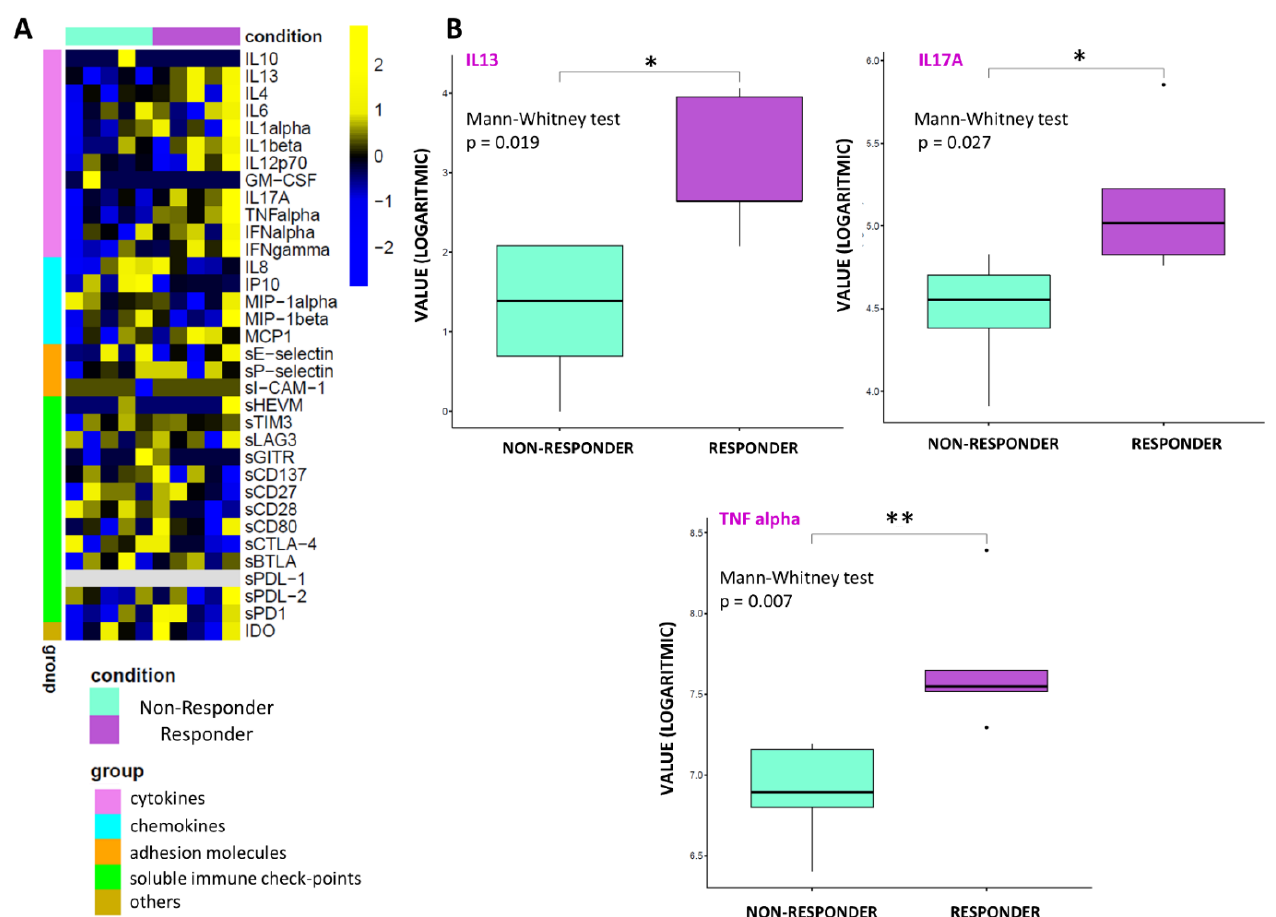
Figure 1. Statistical analysis at T0. ( A ) Heatmap of molecule expression levels (logarithmic scale) at T0 across 10 patients, grouped by therapy responder (violet bars) and non-responder (water blue bars). Colors represent different expression levels, increasing from blue to yellow. ( B ) Boxplot of molecule expression levels (logarithmic scale) in 5 responder patients (violet box) and 5 non-responder ones (water blue box) at T0. p -values ( p ) were obtained by performing a Mann–Whitney test for unpaired samples. Only molecules showing a statistically significant difference between the two groups are shown. Legend: * p ≤ 0.05 , ** p ≤ 0.01 .